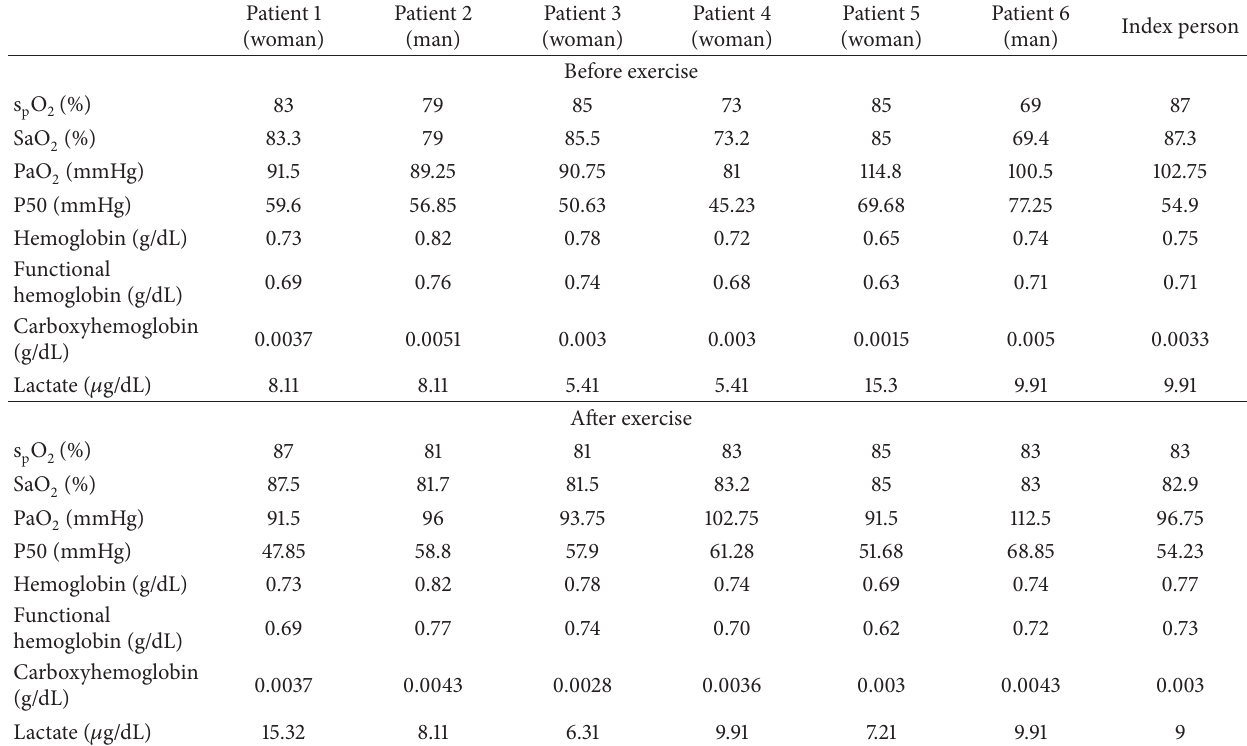
Table 2: Oxygen saturation, measured by pulse oximetry (s O ), and results from arterial blood gas analyses: arterial oxygen saturation p 2 ), partial pressure of oxygen (PaO ), oxygen tension at 50% saturated hemoglobin (P50), and hemoglobin, functional hemoglobin, and (SaO 2 2 lactate concentration before and after 6-minute walking test in 7 patients with Hb